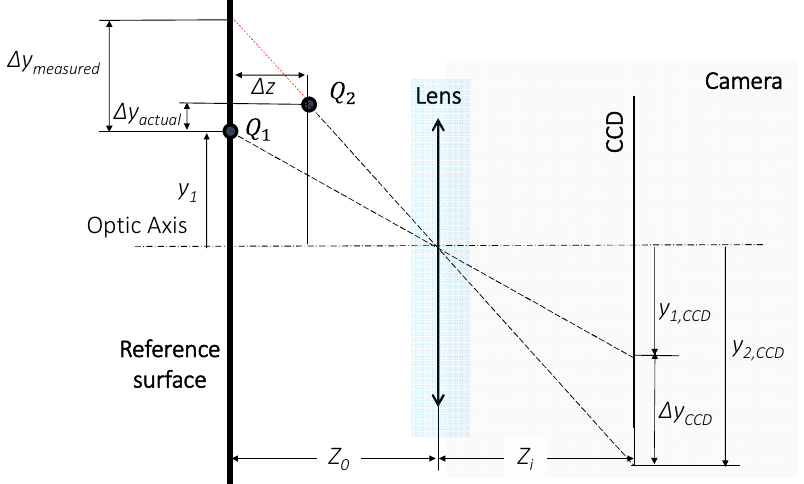
Figure 3. Schematic illustration showing the in-plane error induced in 2D-DIC when the specimen experiences out-of-plane displacements during a deformation process from the Q 1 to Q 2 position.